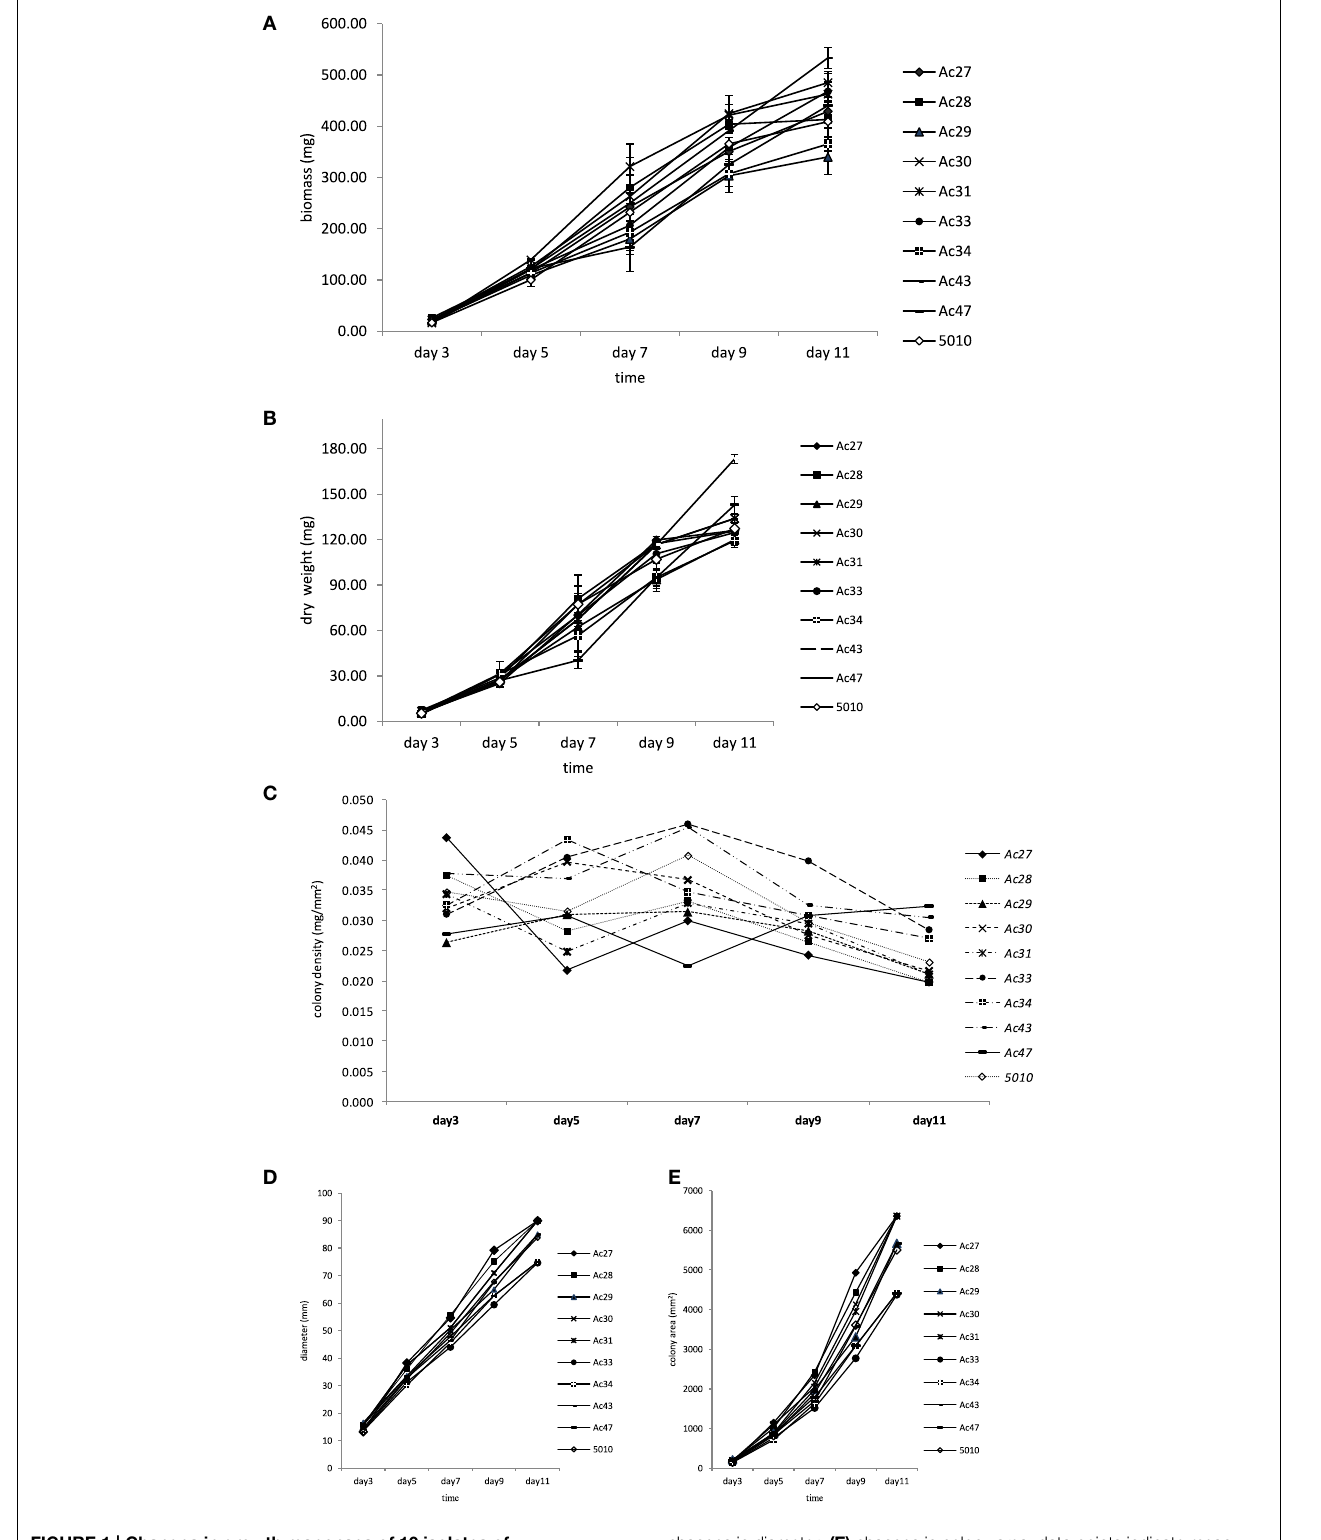
FIGURE 1 | Changes in growth responses of 10 isolates of A. carbonarius plotted against incubation time. (A) Changes in biomass; (B) changes in dry weight; (C) changes in colony density; (D)